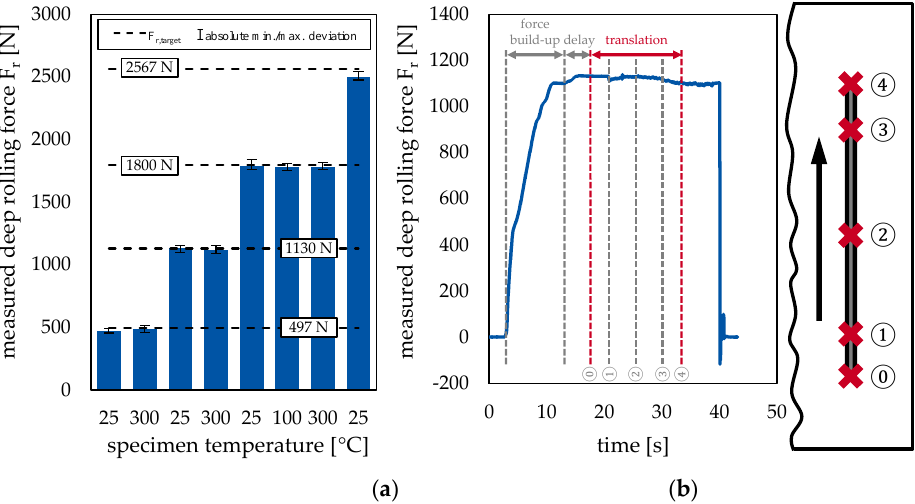
Figure 10. ( a ) Comparison of measured and targeted deep rolling force; ( b ) force measurement during successive deep rolling of single tracks.